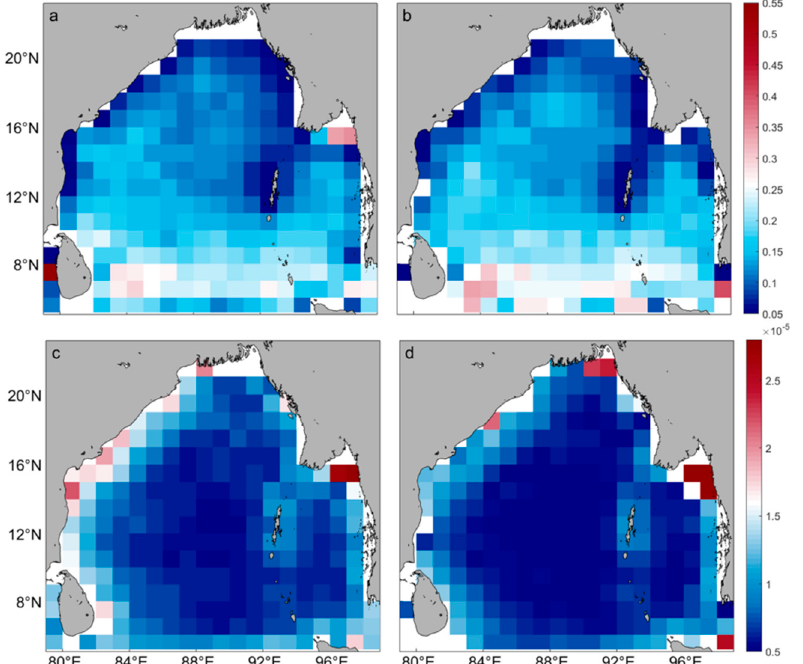
Figure 8. Spatial distribution of absolute values of normalized eddy relative vorticity (divided by local Coriolis parameter for ( a ) CEs and ( b ) AEs. Spatial distribution of strain rate for ( c ) CEs and ( d ) AEs (unit: s − 1 ).